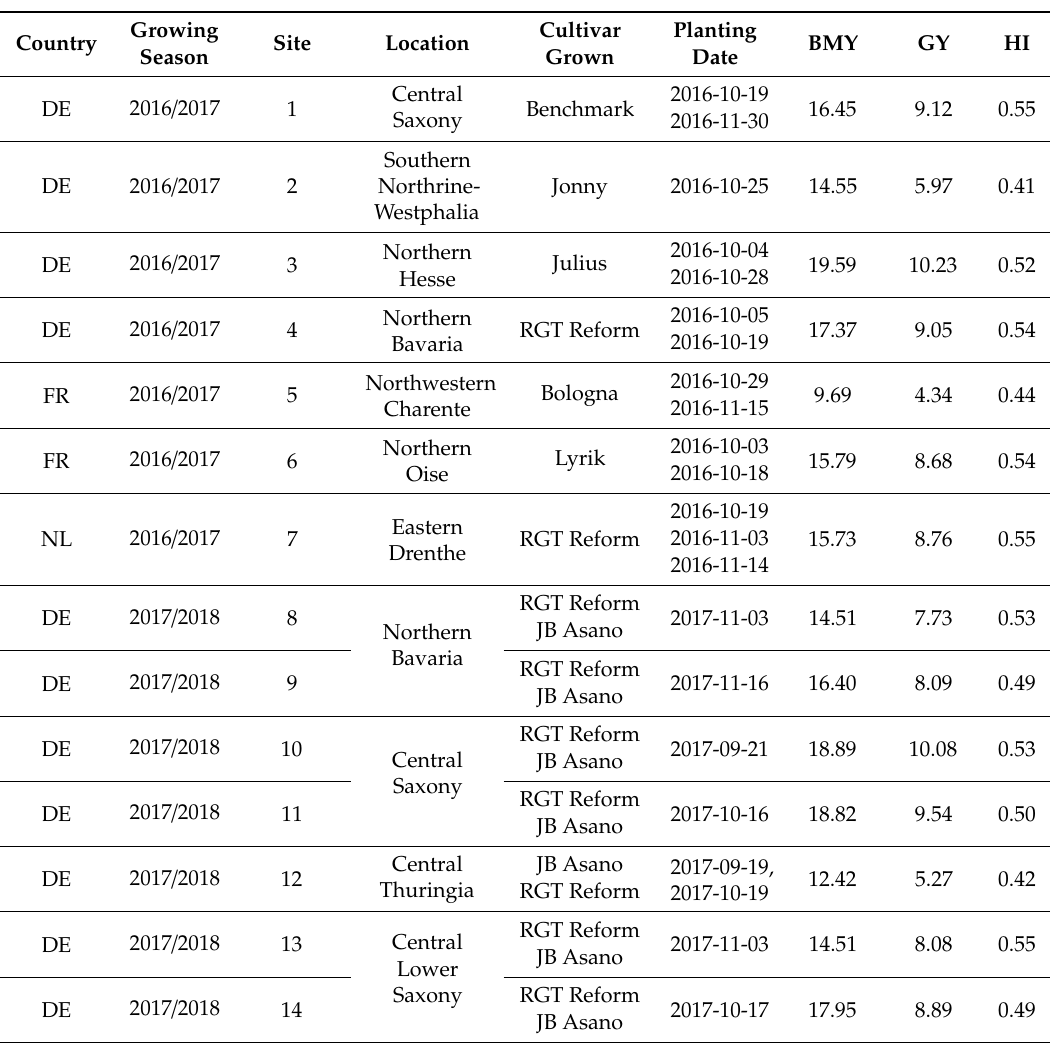
Table 1. List of study sites and locations. BMY: Average Total Aboveground Biomass Yield (t ha − 1 ), GY: Average Grain Yield (t ha − 1 ), HI: Harvest Index (HI = GY / BMY), DE: Germany, FR: France, NL: